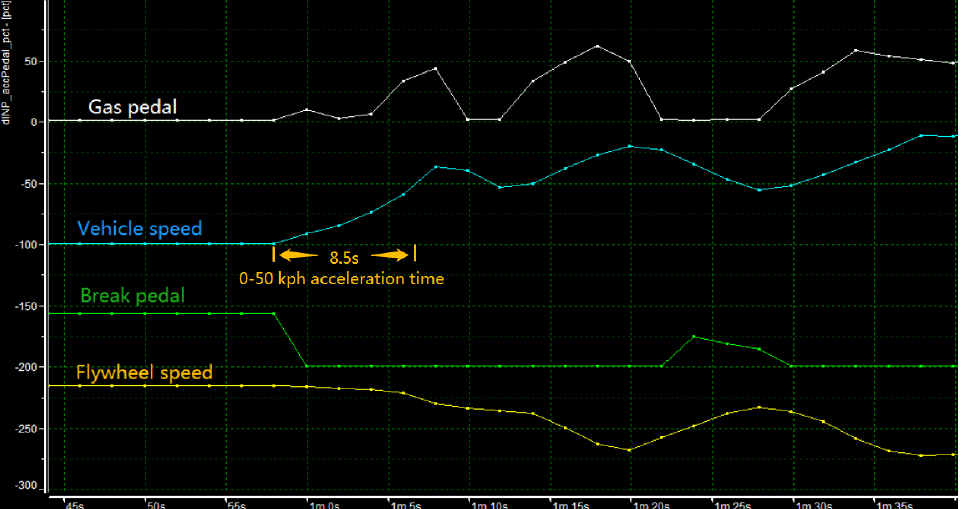
Figure 10. Recorded wave-forms during vehicle start-up process.